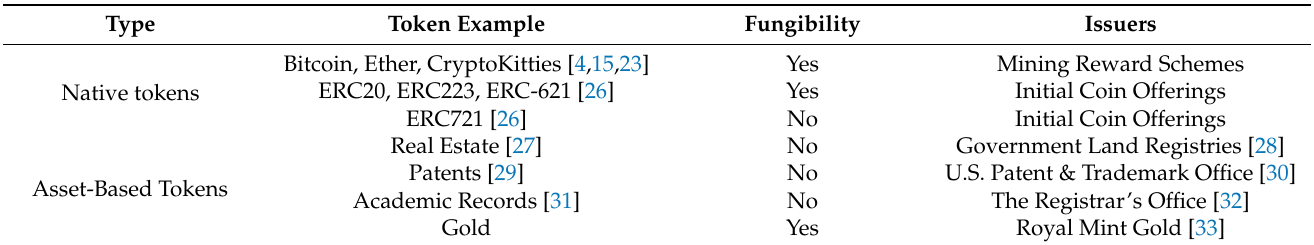
Table 1. Type of digital assets modeled using